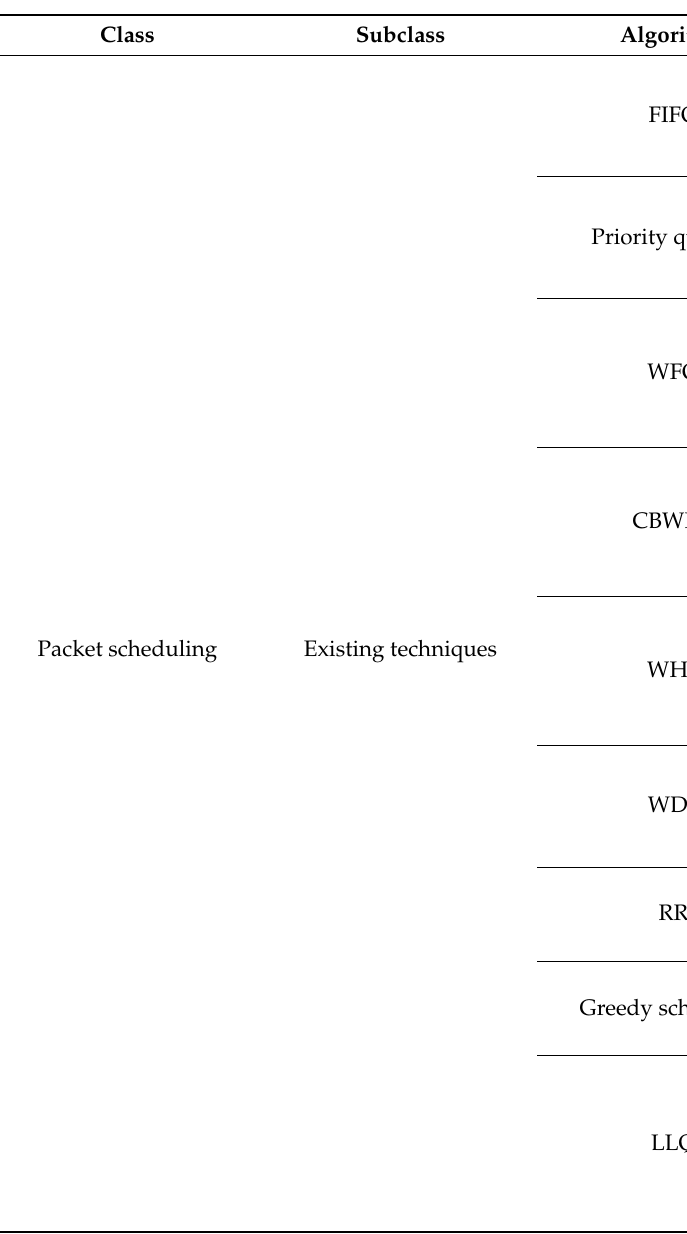
Table 3. Class of techniques for packet scheduling algorithms in mobile ad hoc